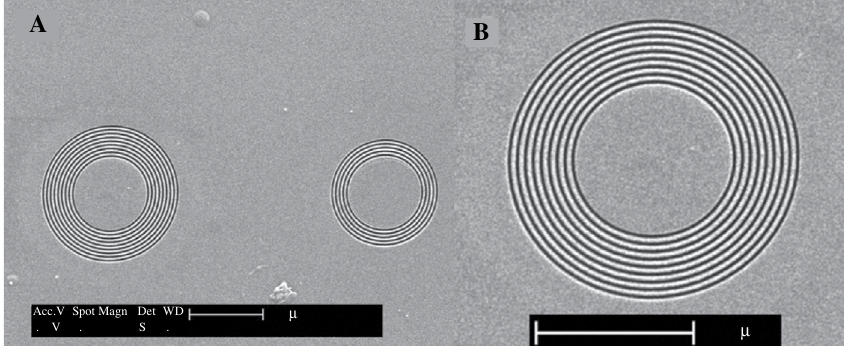
Figure 15 (A) SEM image of the bull’s eye plasmonic antenna with 5-ring and 9-ring. (B) Zoom-in of the 9-ring plasmonic antenna. Adapted from Ref.